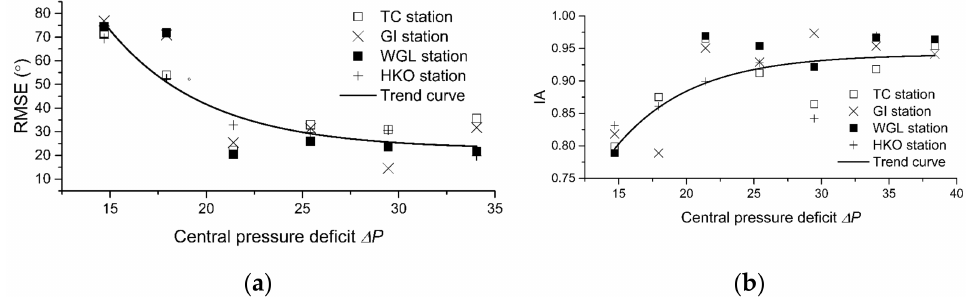
Figure 7. Wind direction error variation as a function of the ∆ P. ( a ) RMSE of wind direction over land; ( b ) IA of wind direction over land.